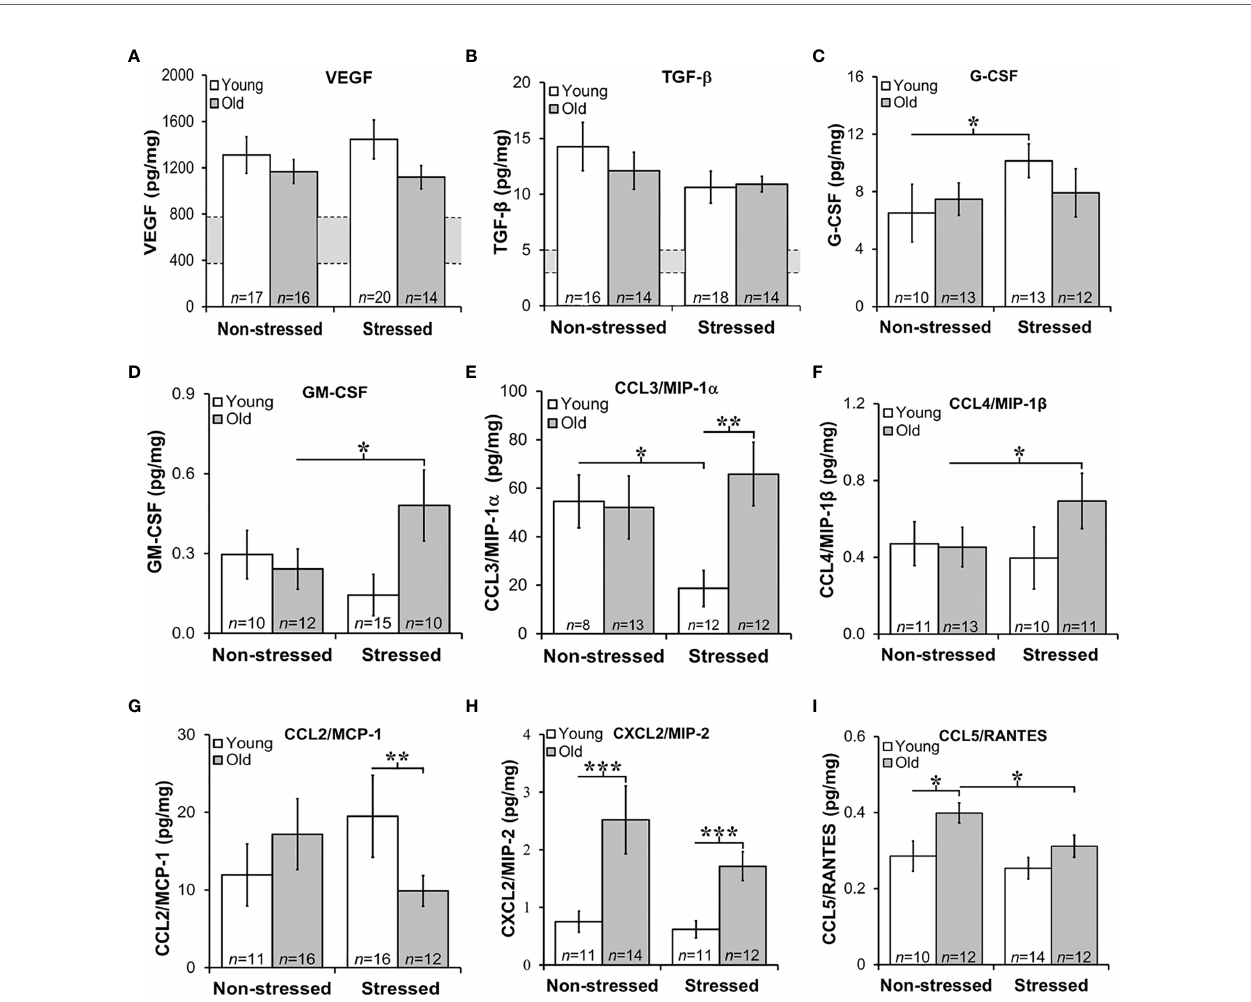
FIGURE 6 | Growth Factors and Chemokines Expression in Prostate Tumors. (A, B) VEGF and TGF- b were highly expressed in RM-9 tumors, regardless of age or treatment group. The gray bar indicates the range of VEGF (A) and TGF- b (B) expression in the murine prostate gland in the absence of RM9 tumors (based on collapsed data from an n of 8 per age group of normal prostate samples; no age-related differences were identi fi ed in these control samples). Mean tumor expression of VEGF and TGF- b expression were higher than in basal prostate levels, but no age- or stress-related differences were uncovered. (C) In young mice, RM-9 tumor G-CSF levels were higher (* p < 0.05) in stressed than non-stressed mice. (D) In contrast, tumor GM-CSF in old mice was greater (* p < 0.05) in stressed than non-stressed mice. (E) CCL3/MIP-1 a was one of the most highly expressed chemokine that was quanti fi ed, and one or two chemokines where effects of both age and stress were identi fi ed. In young mice, stress reduced (* p < 0.05) tumor CCL3/MIP-1 a compared with levels in non-stress mice. In tumors from stress mice, CCL3/MIP-1 a was higher (** p < 0.01) in old than young mice. (F) An increase (* p < 0.05) in tumor CCL4/MIP-1 b levels was observed in old compared with young stressed mice. (G) In the stressed groups, CCL2/MCP-1 was lower (** p < 0.01) in old than young mice. (H) Only effects of age were observed for CXCL2/MIP-2 such that levels were higher in old than young mice regardless of stressed group (*** p < 0.001). (I) Tumor CCL5/RANTES concentrations were reduced in old compared with young stressed mice, but in non-stressed mice, levels were higher in old than in young